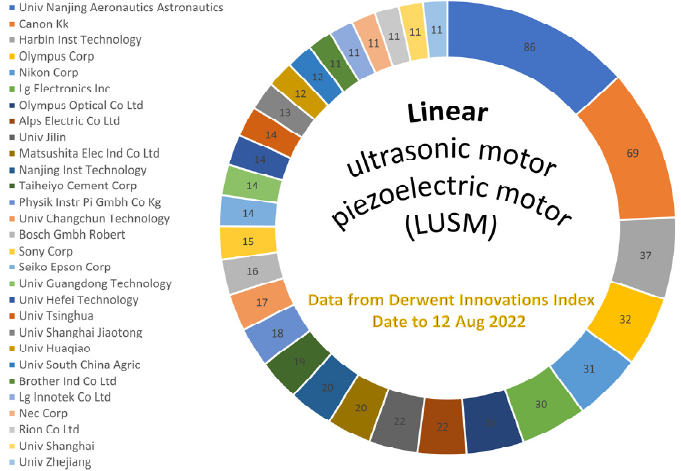
Figure 2. Patent counts of linear ultrasonic motors from Derwent Innovations Index ® date to 12 August 2022 (search item: “linear ultrasonic motors” or “linear piezoelectric motors”). The contact friction model based on Coulomb friction holds that the stator has transient viscous behavior only at the isokinetic point, and the tangential contact force has an abrupt change in the contact process of the stator [39,60,61]. For ultrasonic motors, the friction drive described by Hertzian contact and Coulomb friction theories is highly nonlinear